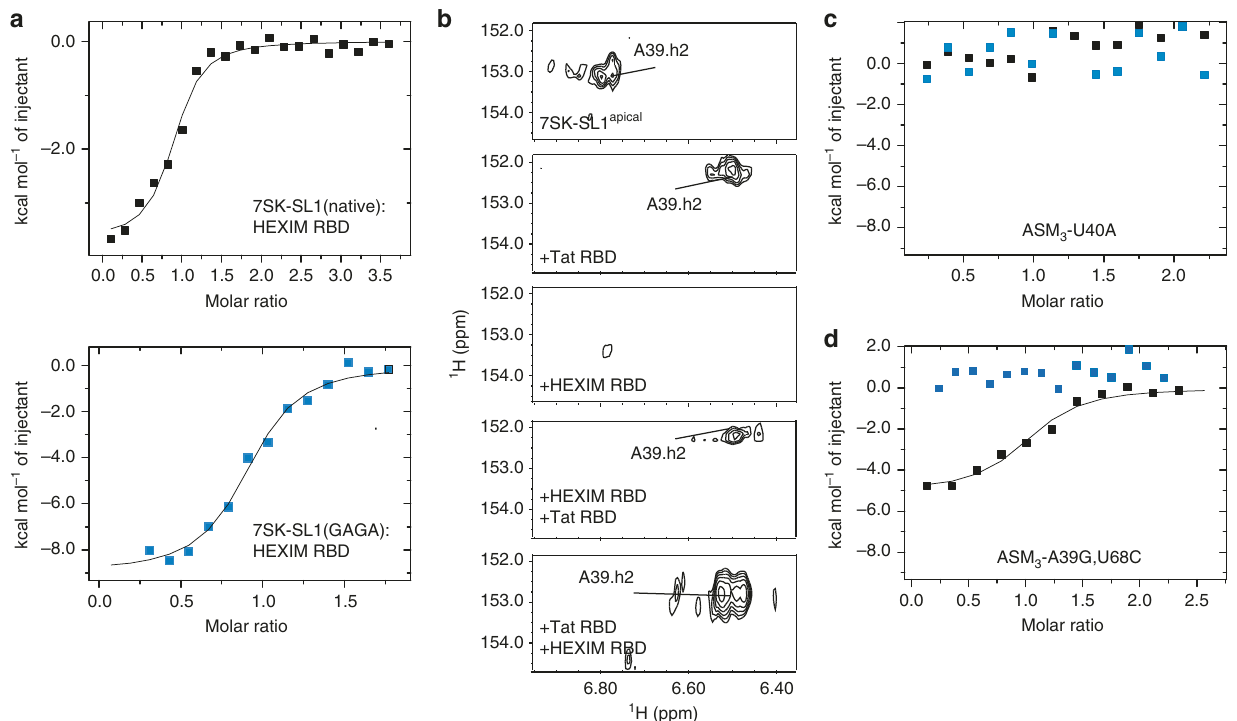
Fig. 4 The role of R52 in HEXIM displacement. a Representative ITC data for HEXIM RBD binding to both 7SK-SL1 apical both with the native (top) and GAGA tetraloop (bottom). A continuous line represents the fi t for one-site binding model. b HMQC spectra of free 7SK-SL1 apical (top panel). Titration of 1 equivalent of Tat RBD leads a characteristic up fi eld shift in the A 39 H2 proton indicative of the A 39 -U 68 Watson-Crick base-pair formation (second panel). On the other hand, titration of fi ve equivalents of HEXIM RBD did not lead to such a shift (third panel). Titration of 1 equivalent of Tat RBD into this HEXIM:7SK complex led to the emergence of the up fi eld A 39 chemical shift characteristic of that of Tat:7SK-SL1 apical , indicating HEXIM displacement (fourth panel). On the other hand, titration of 1 equivalent of HEXIM RBD into a Tat:7SK-SL1 apical complex with 2 equivalents of Tat RBD did not lead to the loss of the up fi eld-shifted A 39 H2 proton shift, indicting lack of Tat displacement by HEXIM (bottom panel). c Representative ITC data for both HEXIM RBD (blue) and Tat RBD (black) binding to the U 40 A mutant, which disrupts the formation of pseudo-ASM 3 . Both constructs gave no heats of binding. d Representative ITC data for titration of both HEXIM (blue) and Tat (black) RBDs into the A 39 G, U 68 C construct that causes a preformed ASM 3 . While Tat RBD was able to engage this motif, HEXIM RBD gave no heats of